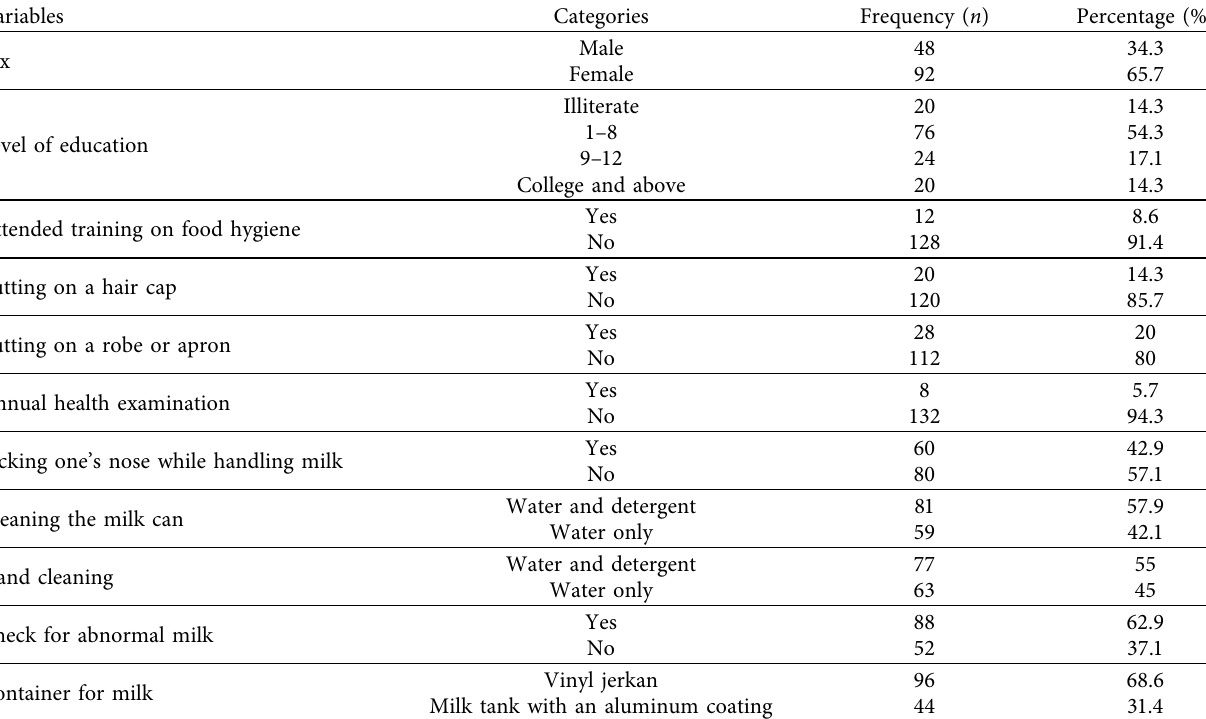
Table 1: Hygiene behaviors and sociodemographic